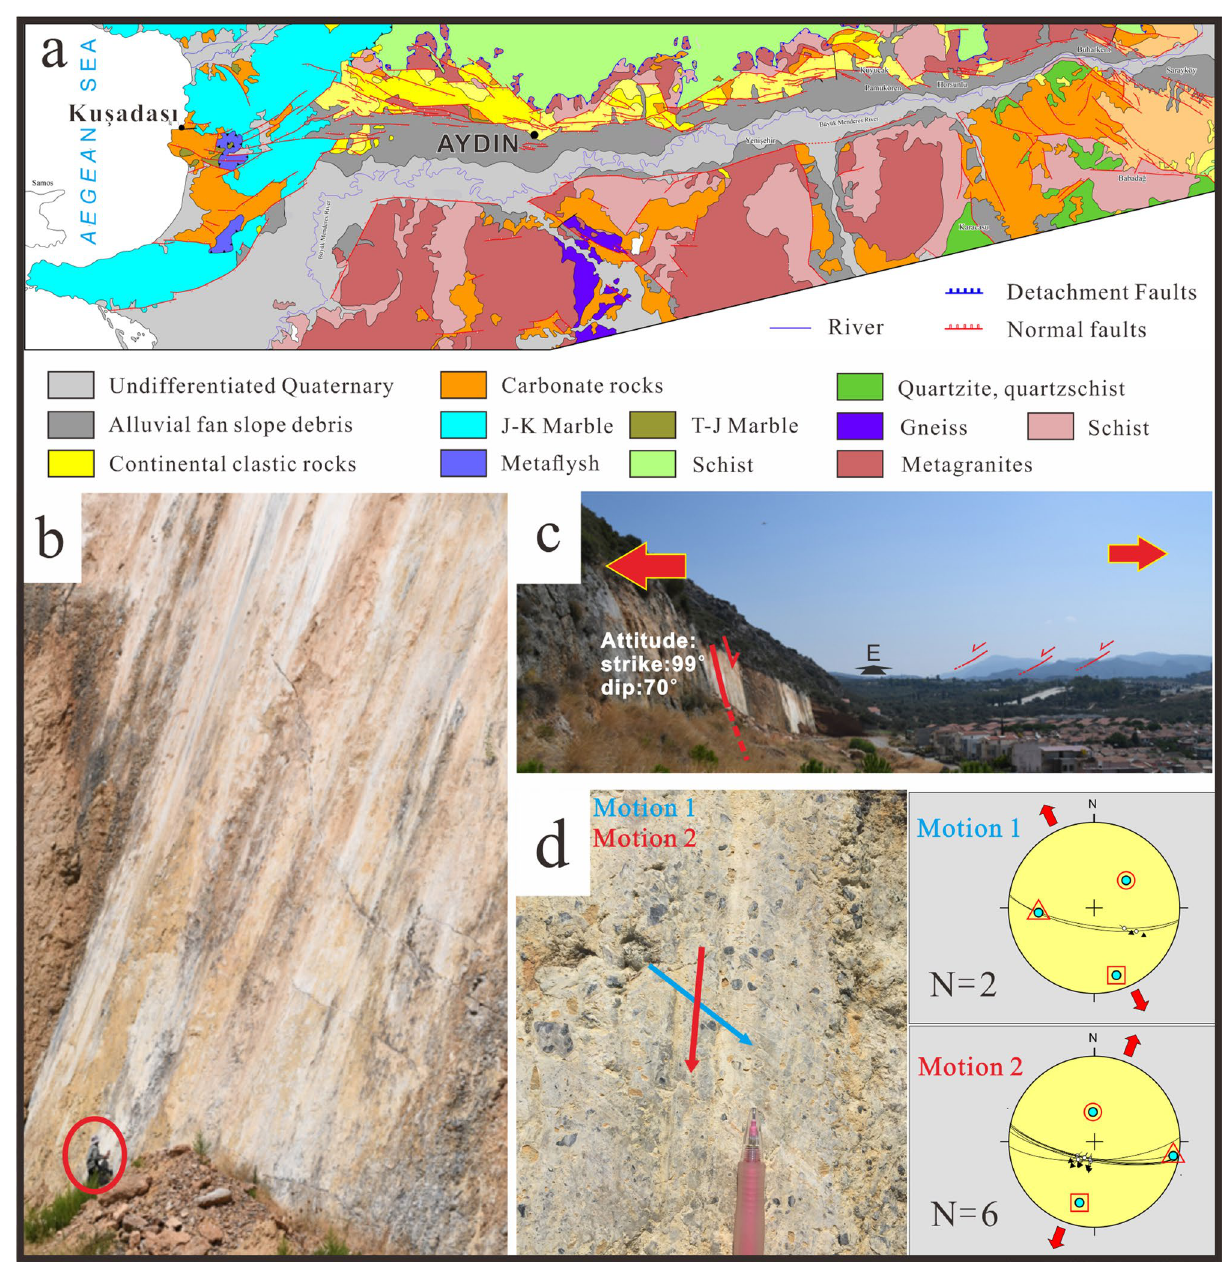
Figure 3. (a) Simplified geological map of Büyük Menderes Graben (compiled from various sources 44,45 ). Photos of the Yavansu fault, Kuşadası fault system, which show ( b) approximately 30 m highly polished slickensided surface with normal-sense slickenlines; notice the 1.8 m tall person in red circle for scale. (c) The synthetic and antithetic normal active faults under near N-S extension regime plunging into the graben, where human constructions are on the hanging wall exactly next to the fault surface. This presents a tremendous risk for geological hazards. Black arrow and character indicate the camera direction (d) fault surfaces of the Kuşadası fault showing multiple slip events and their kinematic features, Schmidt lower hemisphere equal-area projections of fault slip data, the arrows are striations 46 (see Table 2 for